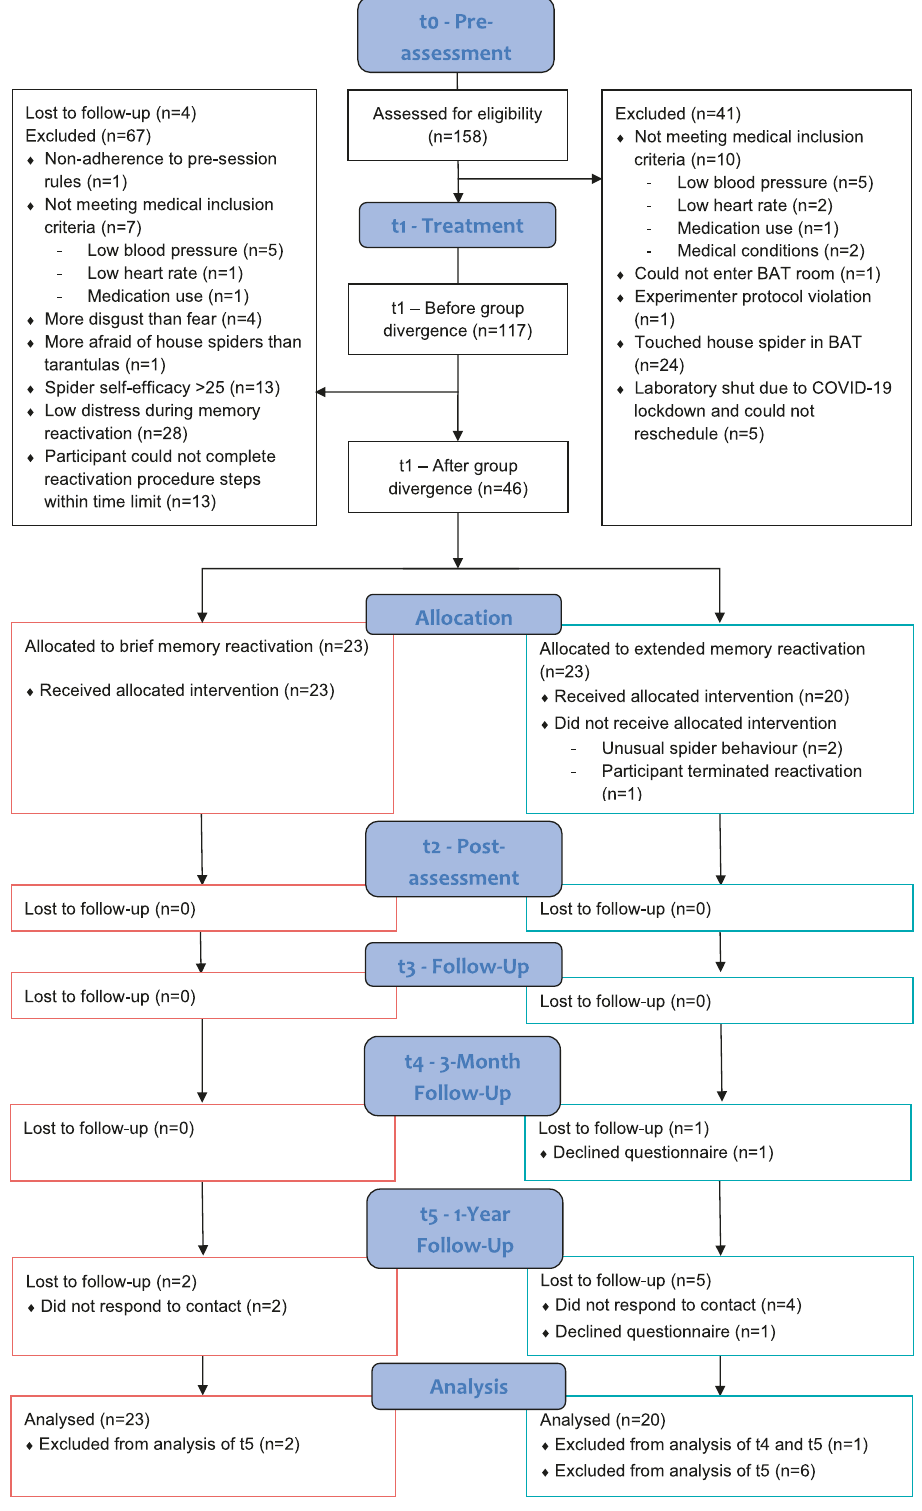
Fig. 1 The participant fl ow and in-session exclusion criteria. Blood pressure was de fi ned as too low when the systolic blood pressure was below 100 or the diastolic blood pressure was below 60. Heart rate was too low if it was below 60, or below 50 for those who did more than 7 h of exercise a week, unless the heart rate rose above the cut-off after 2 min of light exercise. For more speci fi c details on all exclusion reasons see Supplement B. BAT Behavioural Approach